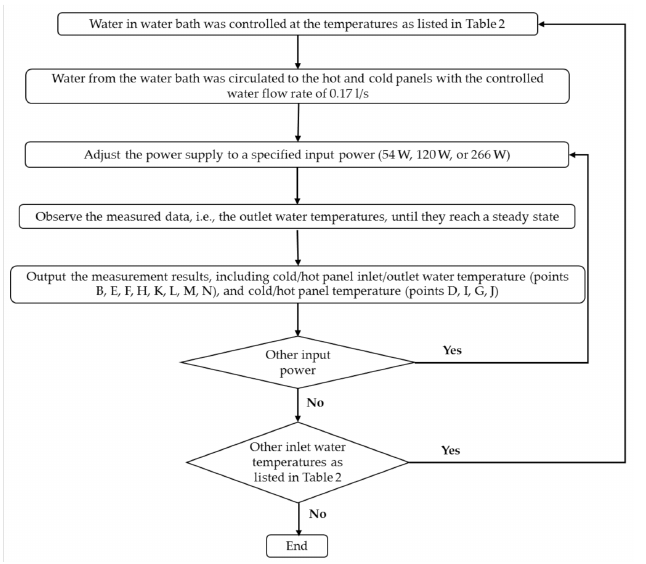
Figure 4. Experimental